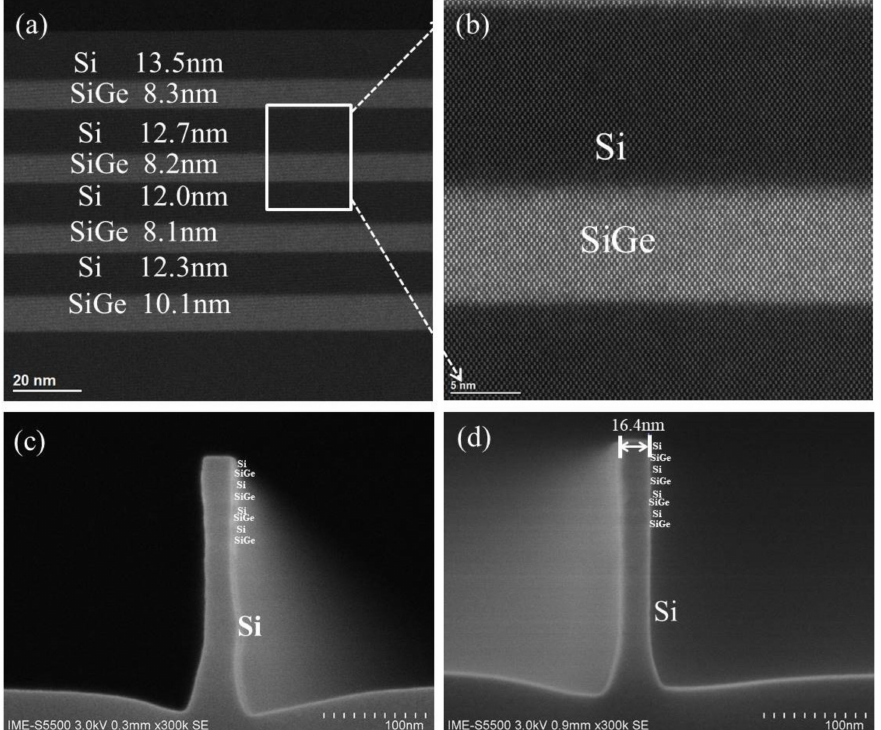
Figure 2. ( a ) HRTEM images of stacked Si 0.7 Ge 0.3 /Si multilayer; ( b ) its magnified images at the Si 0.7 Ge 0.3 /Si interfaces. ( c ) Four-period stacked SiGe/Si fin profile with HBr/O 2 /He plasma under bias voltage of − 90 V, ( d ) under bias voltage of − 100